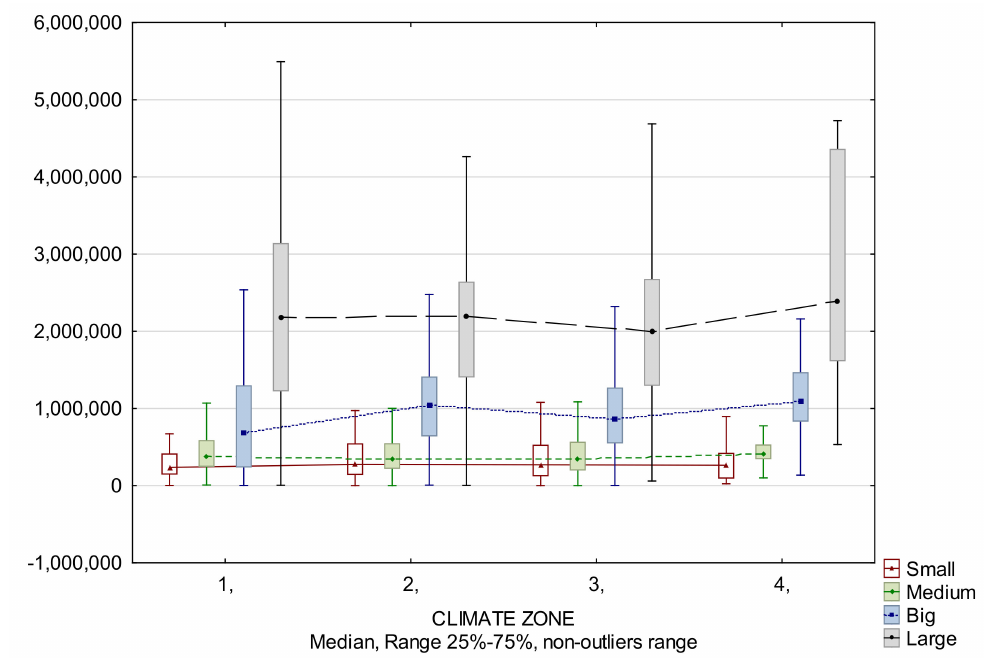
Figure 8. TEC by the size of the hospitals related to climate zones in